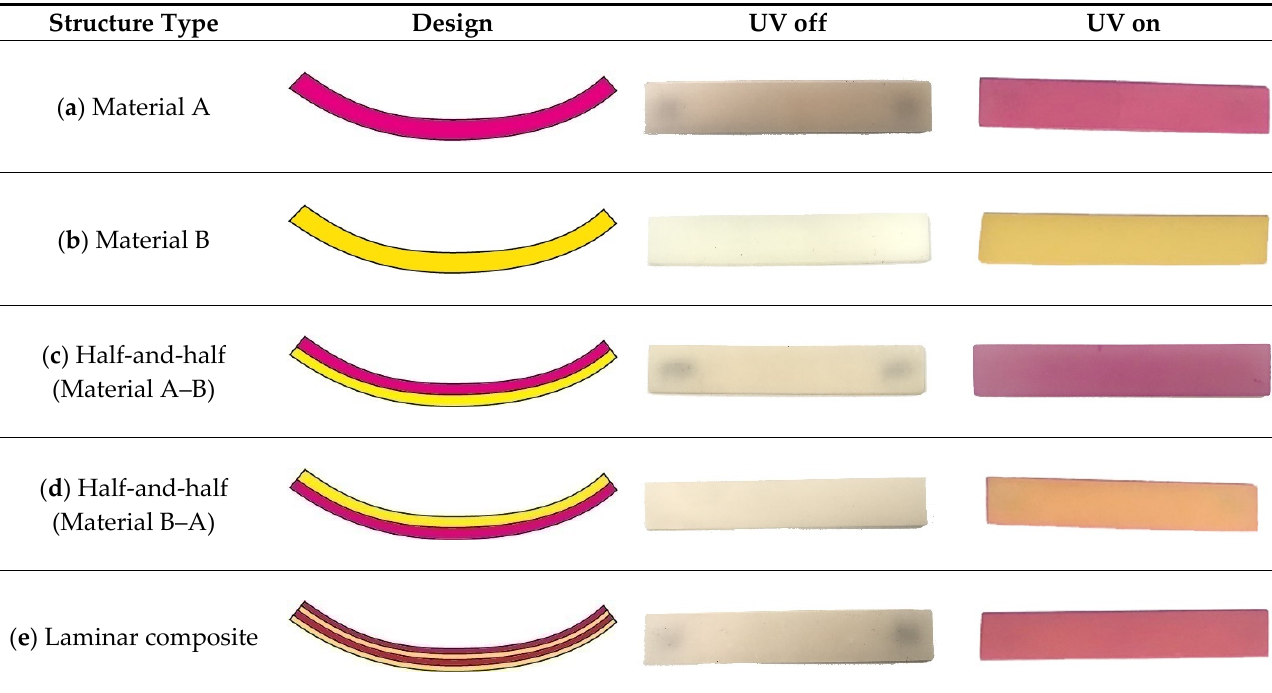
9 of 19 Figure 9. Schematic diagram of the suggested process: ( a ) photo-polymerization of material A; ( b ) moving the separator for material switching; ( c ) photo-polymerization of material B. 3.2. Three-Point Bending Test 3.2.1. Fabricated Specimens As shown in Figure 10, a total of 5 types of specimens were prepared according to the material and printing method. Since the manufacturer did not provide the mechanical